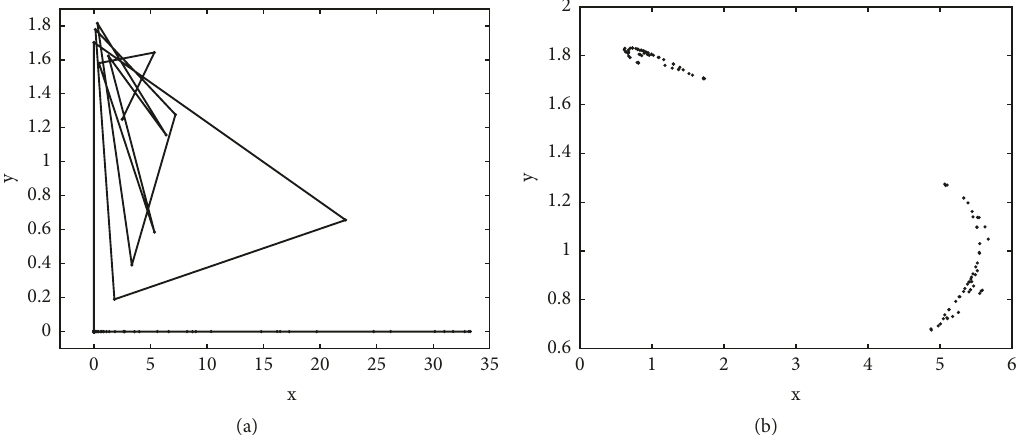
Figure 6: (a) Convergence towards attractor 𝐴2 . (𝐹,𝐺) = (91,5) . Initial condition (𝑥 0 , 𝑦 0 ) = (2.5,1.25) . (b) Chaotic dynamics where both species survive. (𝐹,𝐺) as in Figure 6(a) but (𝑥 0 ,𝑦 0 ) = (2.5,1.7)